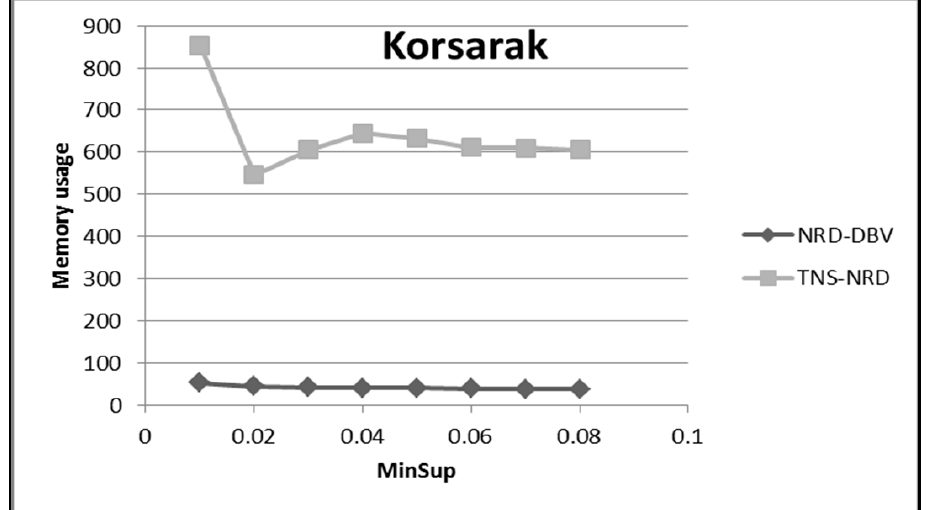
Figure 25. Comparison of memory usage for the TNS with the NRD-DBV algorithm for (Korsarak) dataset.